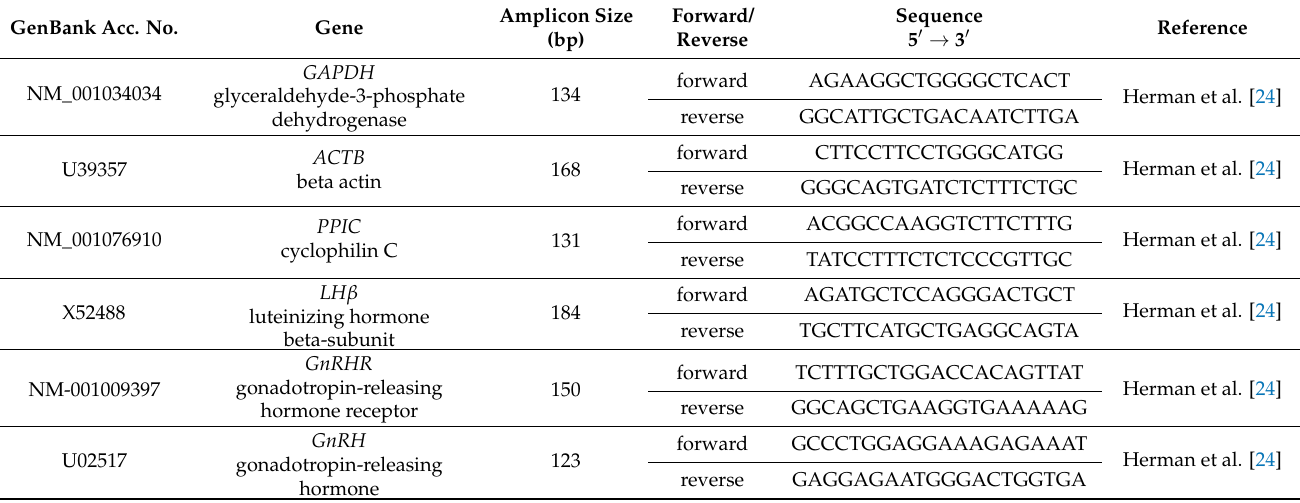
Table 1. All genes analyzed by real-time PCR are listed with their full names and abbreviations. GenBank Acc.